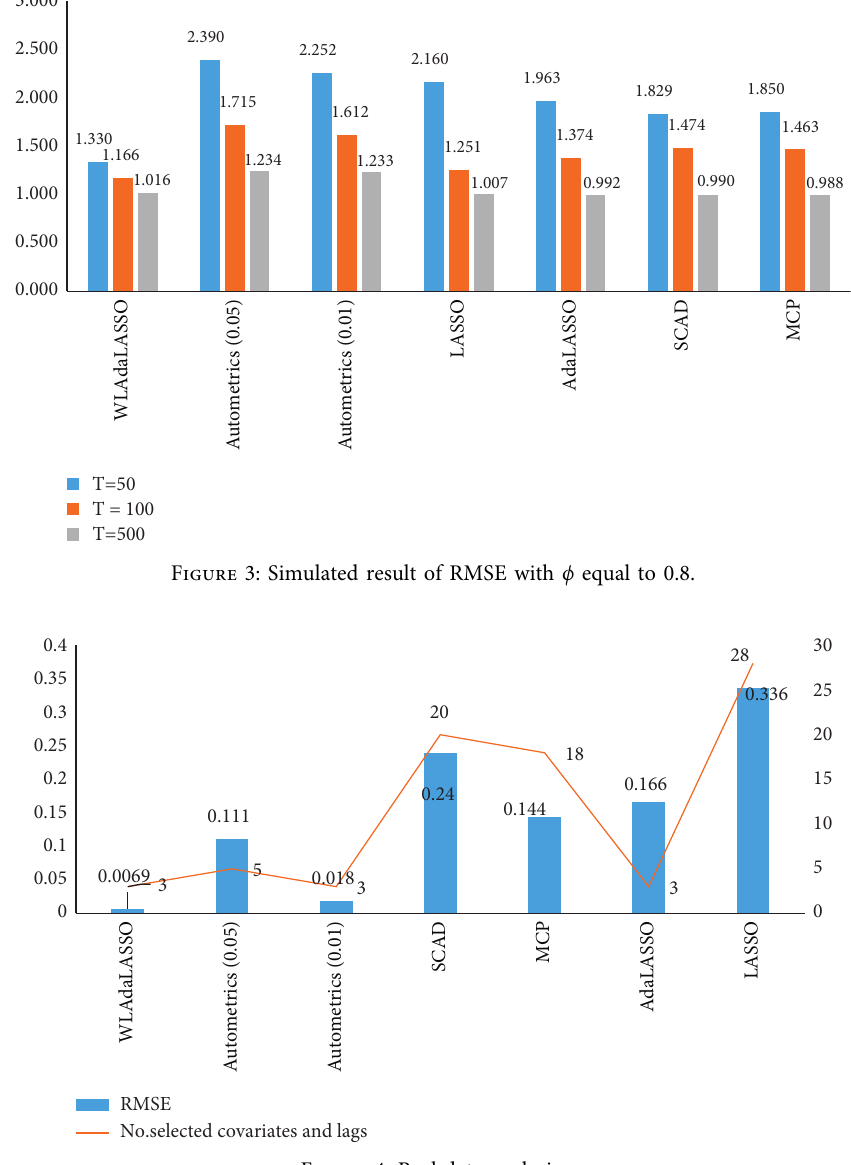
Figure 4: Real data